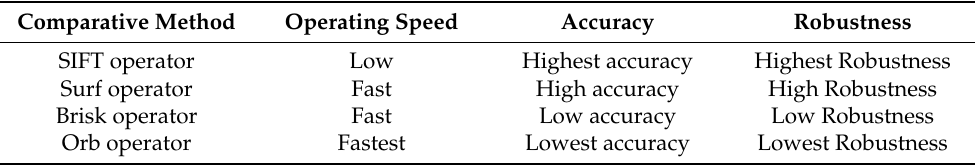
Table 2. Comparison of four feature point matching algorithm.